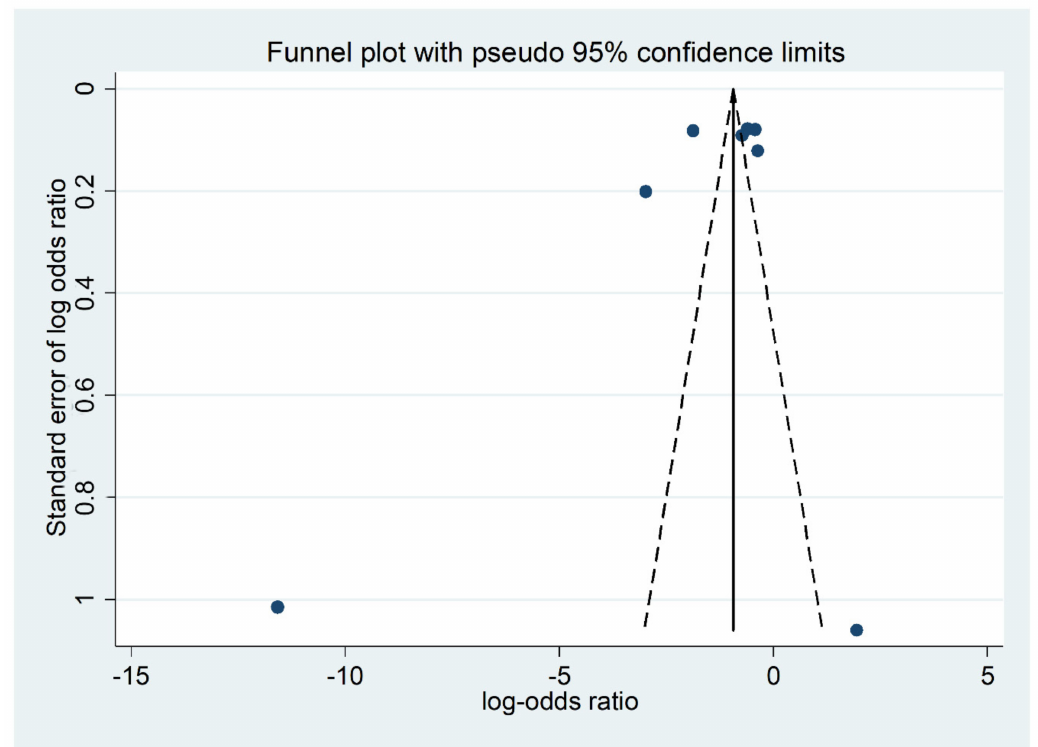
Figure 10. Funnel Plot represented from the eight pooled trial and model-based economic-evaluation studies of Oral Health Promotion Programs (OHPPs), with log-odds ratios displayed on the horizontal axis and the standard error of the log-odds ratios displayed on the vertical